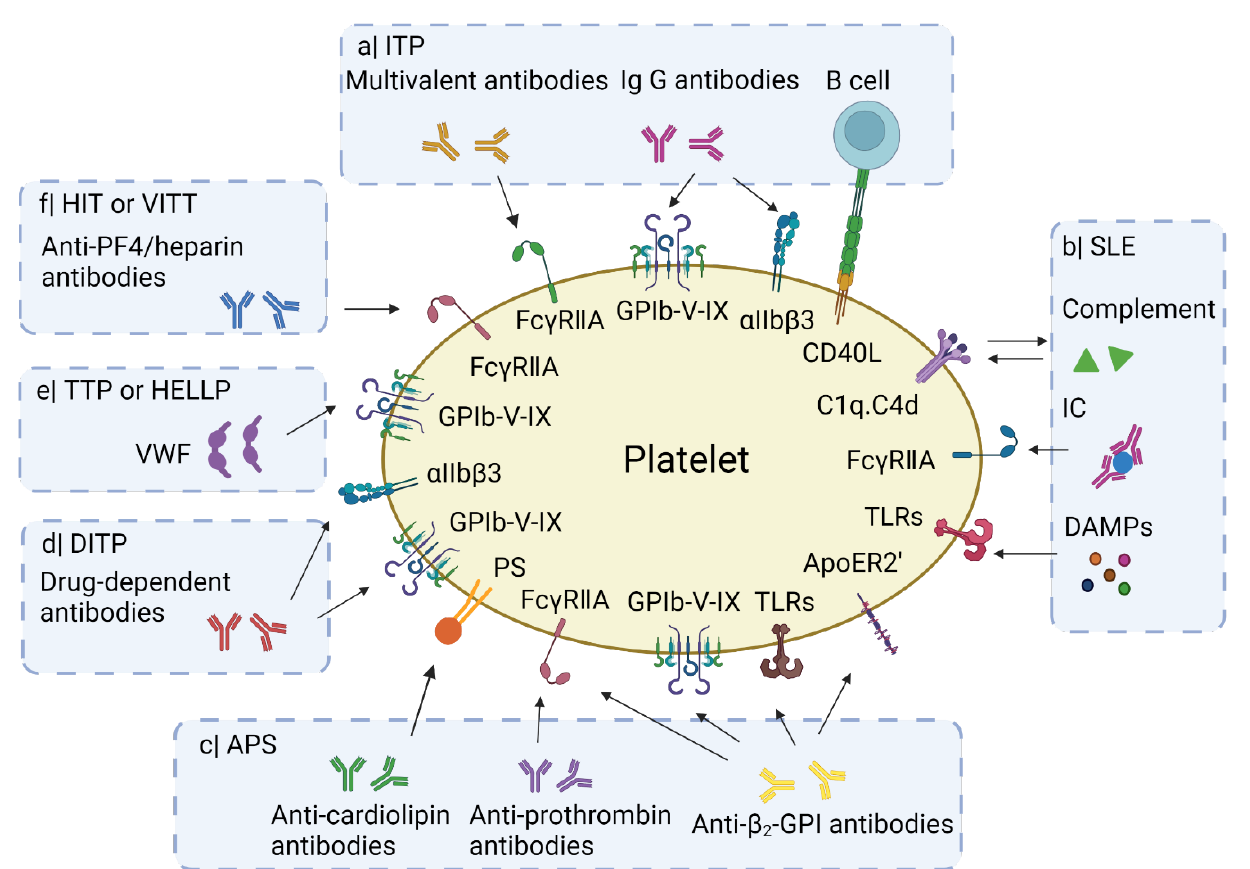
Figure 1. Overview of mechanisms leading to platelet activation in types of IIT. a| Frequently in ITP, IgG auto-antibodies bind to GPIbα or αIIbβ3 on the platelet membrane. Incidentally multivalent auto -antibodies induce platelet activation via FcγRIIA receptors. The glycoprotein CD40L (CD154) on activated platelets can interact with B cell CD40, inducing B cell proliferation. b| In SLE, immune complex (IC) and DAMPs (e.g., HMGB1 or S100A8/9) activate platelets through binding to surface receptors such as FcγRIIA and Toll -like receptors (TLRs). The IC may also activate the complement system leading to deposition of complement fragments (C1q, C4d) on the platelet surface, which potentiates their activation. c| Anti-cardiolipin, anti- β 2 -GPI and anti-prothrombin antibodies can induce platelet activation in APS patients. d| In TTP or HELLP, ultra- large VWF multimers provoke the agglutination of platelets via GPIbα. e| In HIT or VITT, antibodies to PF4/heparin comple xes bind and activate platelets via FcγRIIA receptors. For further explanations, see text. Created with Biorender.com.